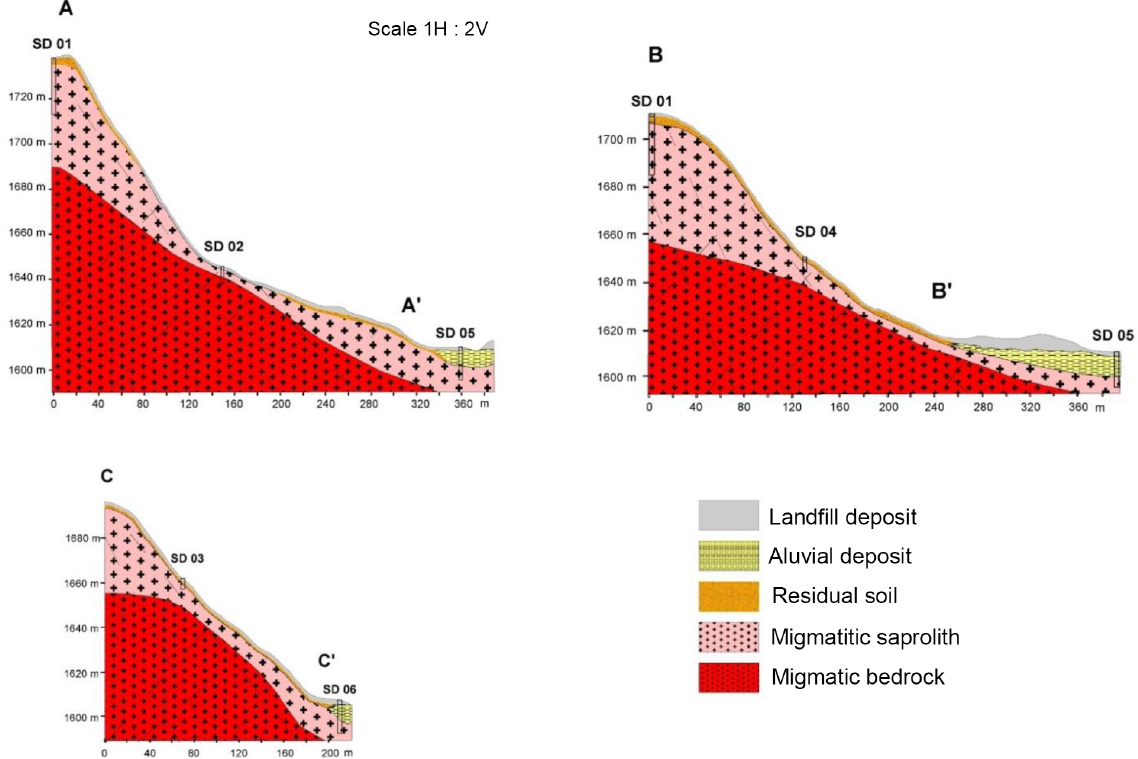
Figure 4. Geological–geotechnical profiles of the study area derived from the geotechnical